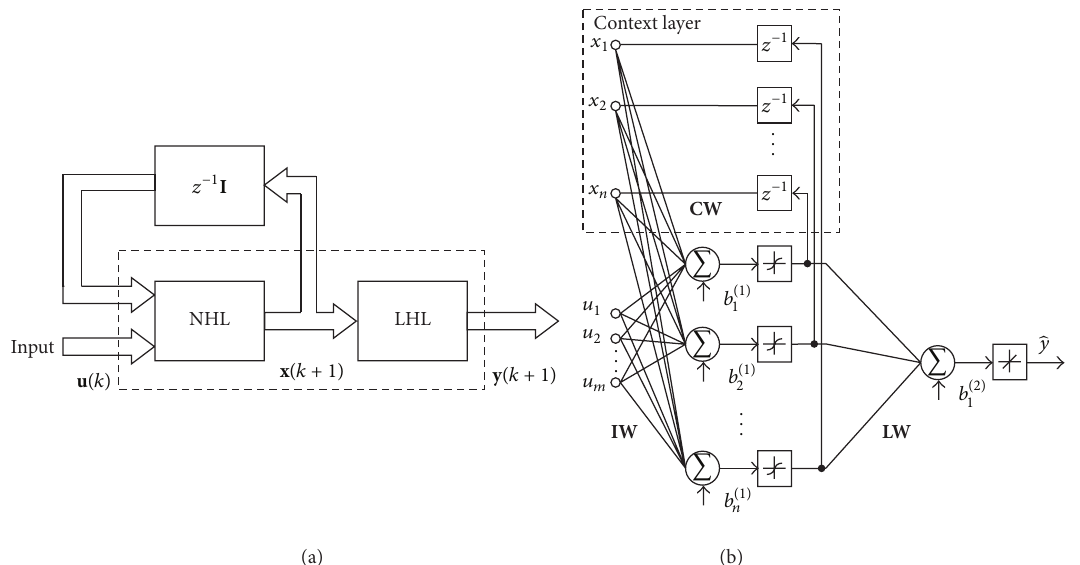
Figure 7: State diagram of Elman network (a) and network structure (b) where u (𝑘) is input vector, x (𝑘 + 1) is state vector, y (𝑘 + 1) is output vector, NHL is nonlinear hidden layer, LHL is linear hidden layer, 𝑧 −1 is unit delay, IW is input layer weight matrix, CW is context layer weight matrix, LW is hidden layer weight matrix, 𝑏 (𝑘) 𝑙 is 𝑙 th neuron bias in 𝑘 th layer, and ̂𝑦 is network output.